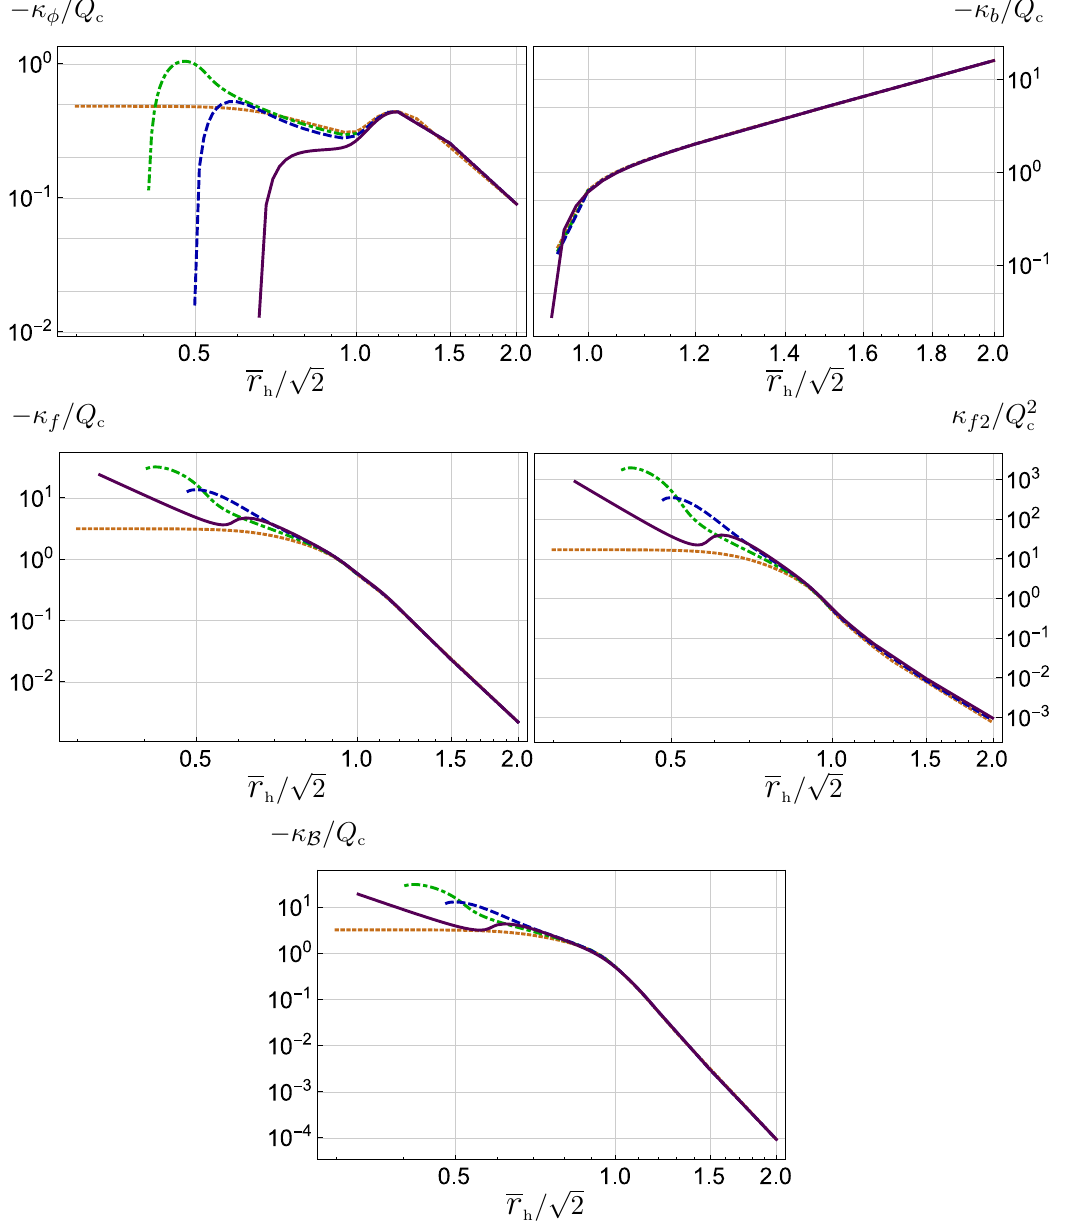
Figure 23. UV coe(cid:14)cients as functions of the radius of the horizon (see legend in (cid:12)gure 21). The small black holes are described near the IR by the scaling solution discussed around eqs. (F.1) and (F.3), and they are thermodynamically unstable since the entropy decreases with the temperature, making the speci(cid:12)c heat negative. For the large black holes this also occurs if the temperature is su(cid:14)ciently high, re(cid:13)ecting the presence of the Landau pole in the UV, as explained in section 3.1. For a small range of temperatures just above T the large black hole solutions possess a positive speci(cid:12)c heat and therefore are not locally thermodynamically unstable against energy density (cid:13)uctuations at (cid:12)xed charge density. We have not examined whether other possible instabilities are